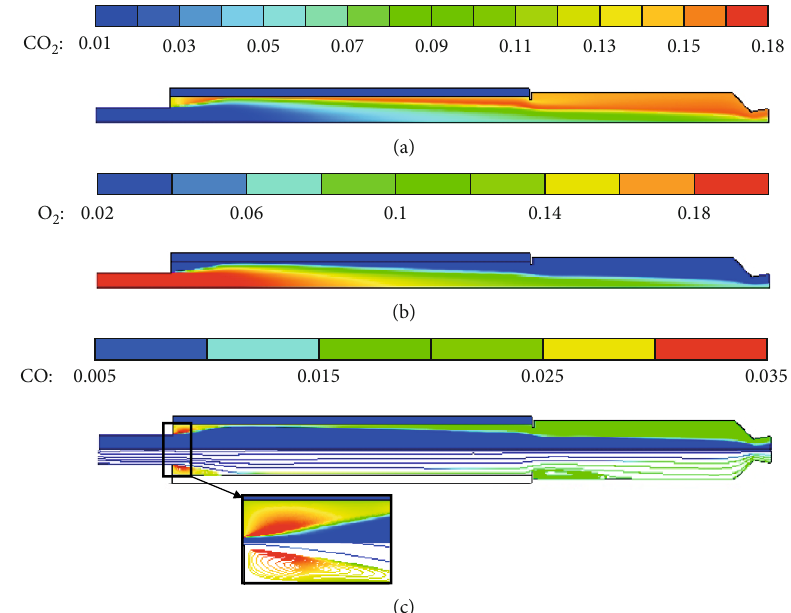
Figure 16: Contours of CO